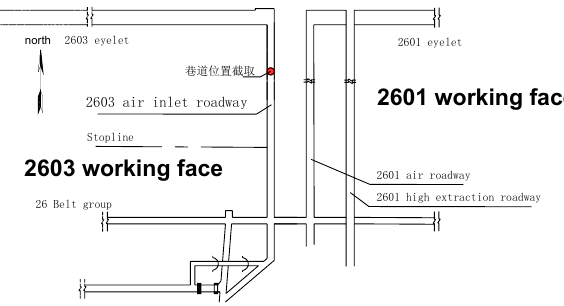
Figure 6. Location of the observation point in the